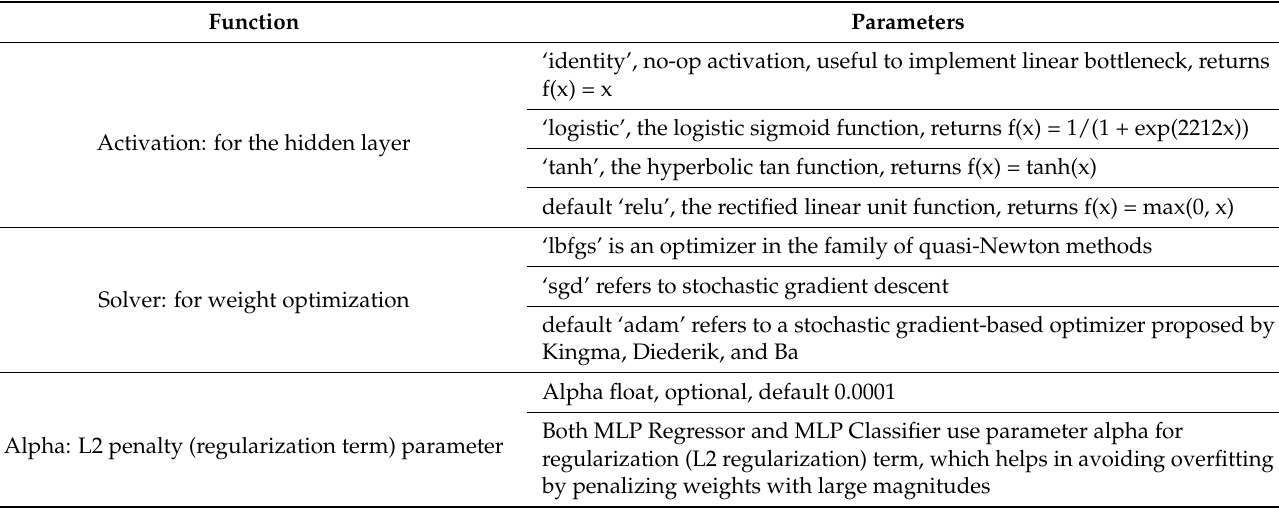
Table 11. MLP parameters (activation, solver,